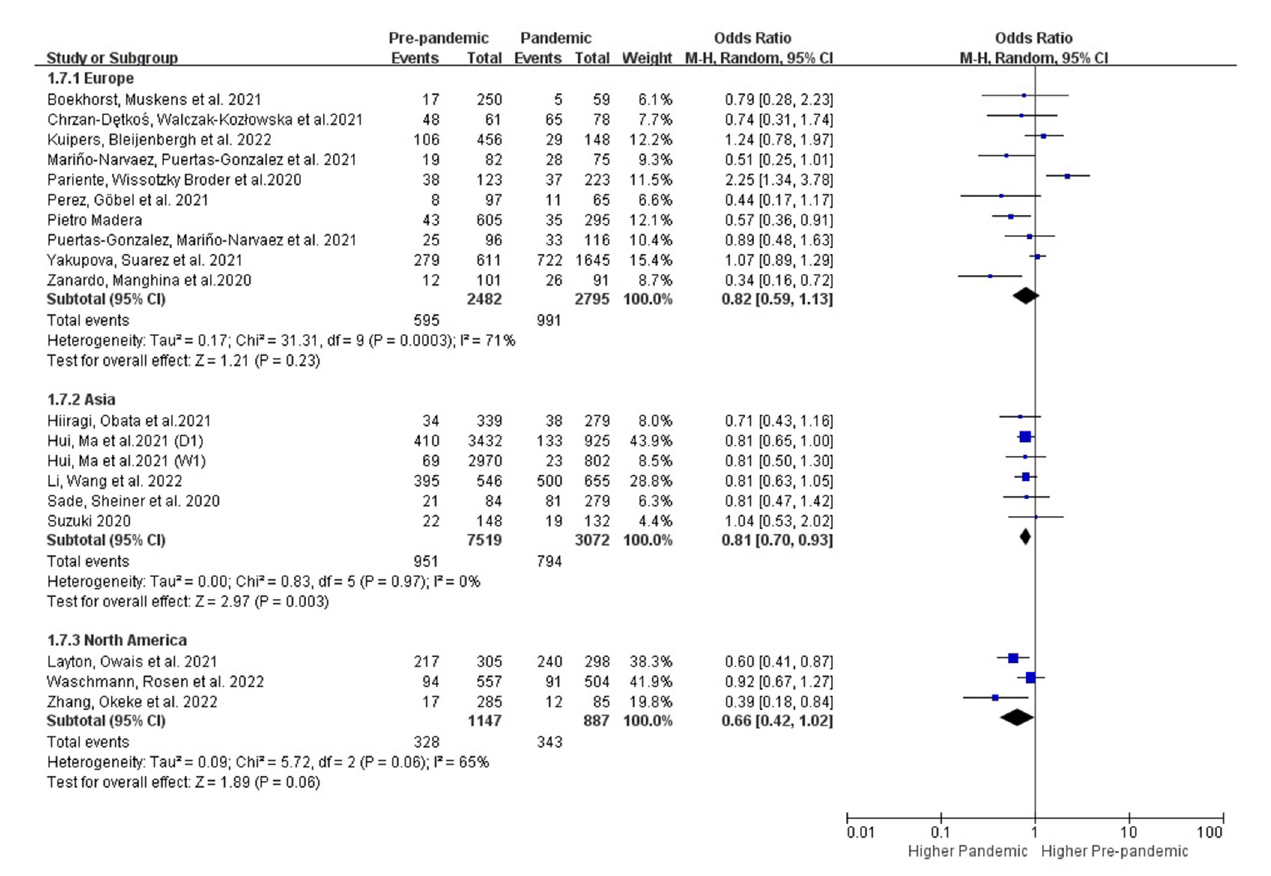
FIGURE7 Subgroup analysis comparing the prevalence of PPDS before and during the COVID-19 pandemic according to different